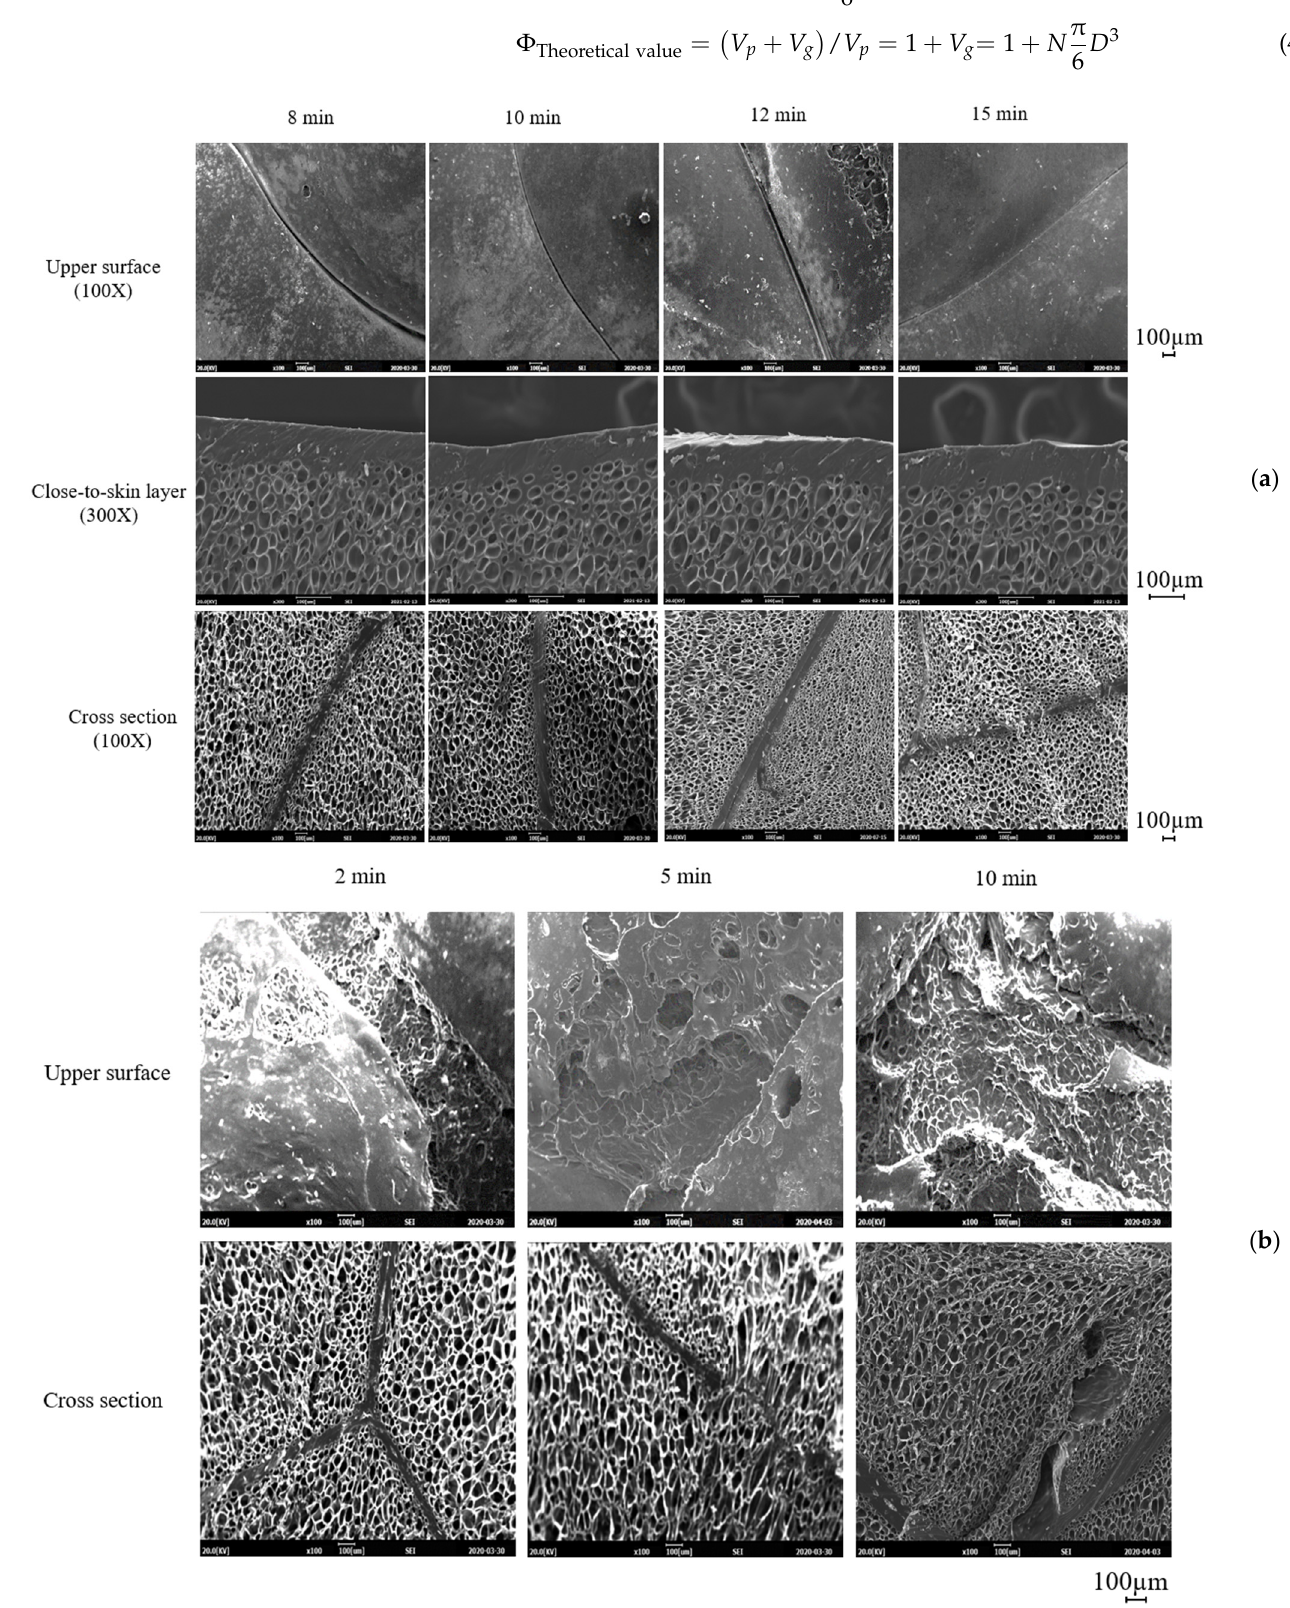
Figure 6. SEM micrographs of the surface and cross section of ETPU sheets molded at ( a ) 145 °C and ( b ) 150 °C.